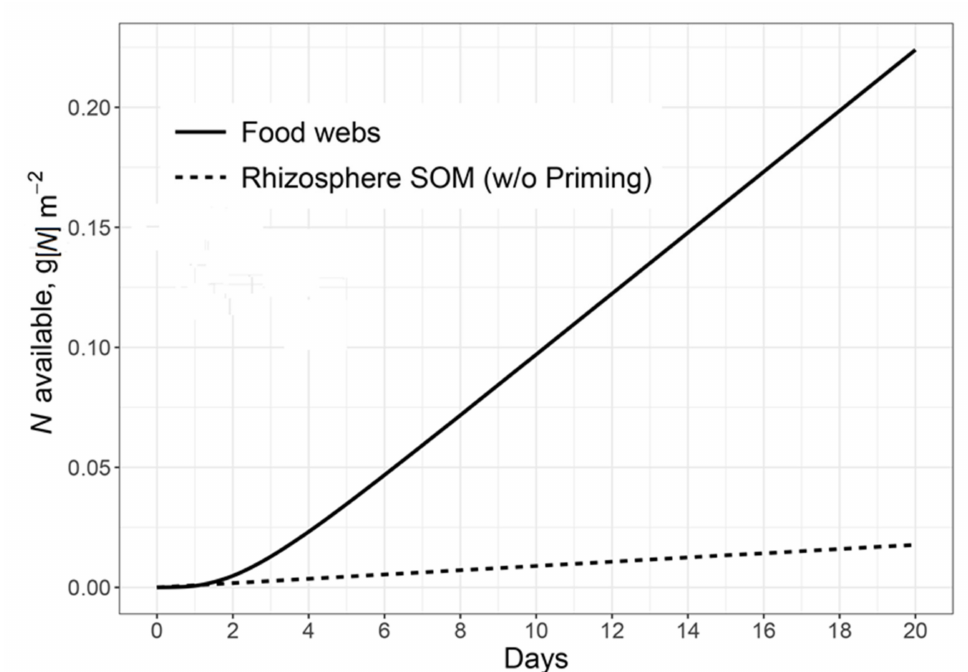
Figure 6. Cumulative N mineralization available for root uptake in the rhizosphere soil only. N is mineralized from two sources: available N produced in food webs (solid line) and mineralized N in rhizosphere SOM without exudate input (dotted line). C:N of root exudates is 40. The lag phase of the available N production within food webs is the effect of the daily time step of the model because microbial biomass needs to grow first before PE can be